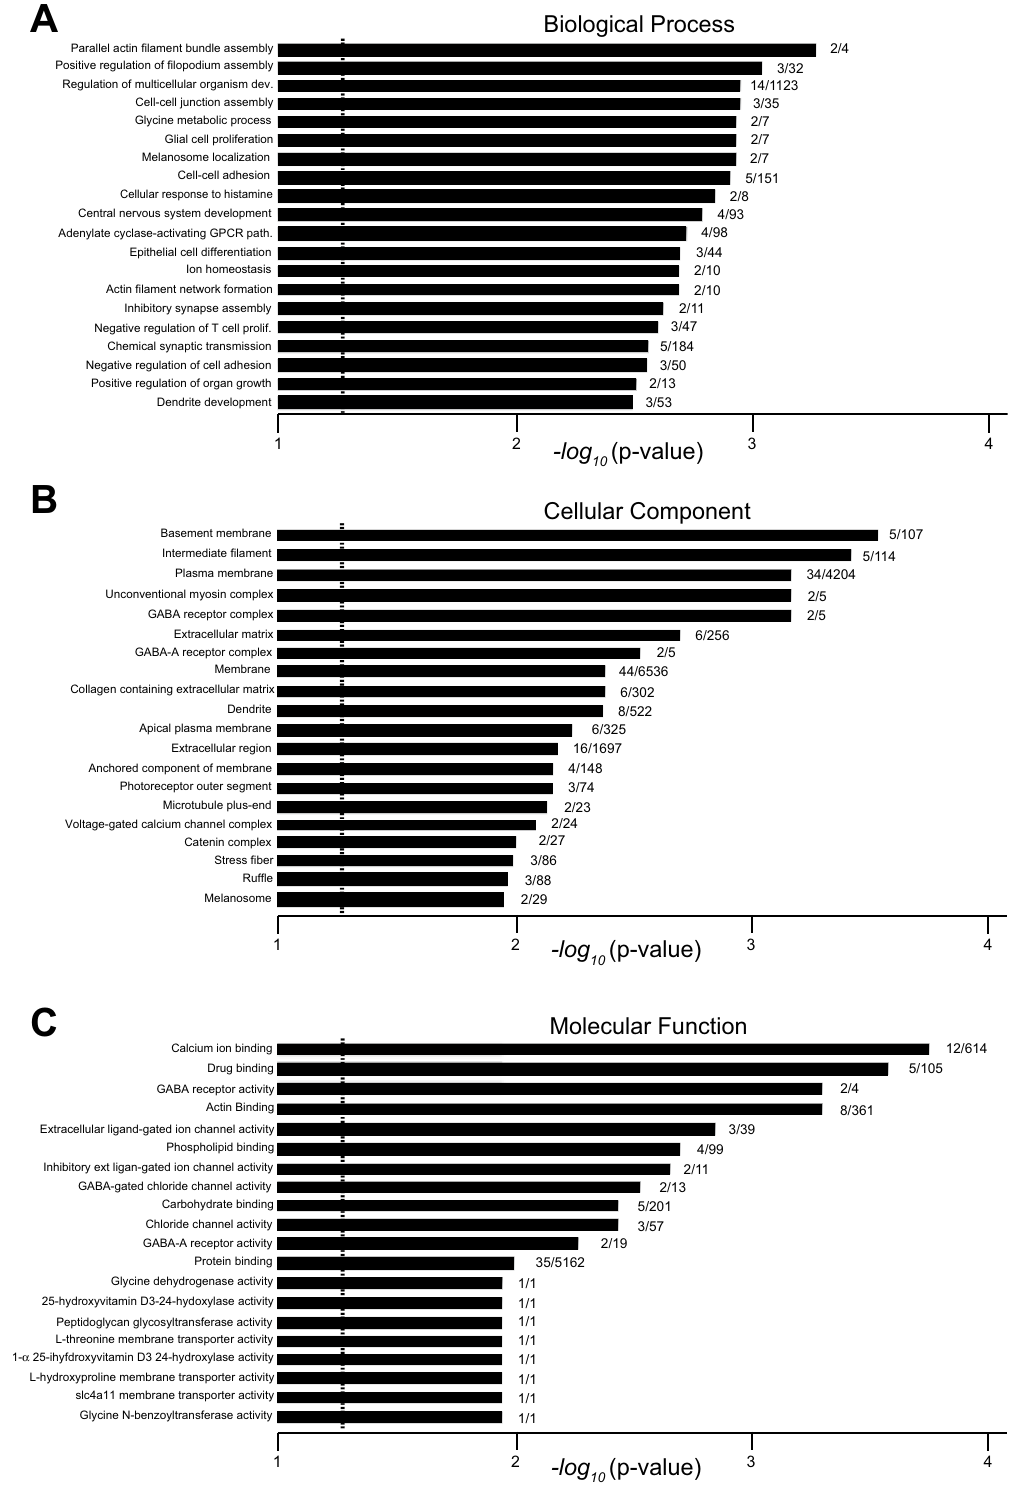
Figure 2 . Gene ontology (GO) analysis of genes differentially expressed in slc4a11 −/− mouse cornea. The X-axis represents the rank of GO terms based on statistical significance of the alterations of gene expression for genes in a GO category. Numbers beside bars are number of altered genes identified in the pathway/ number of genes in that GO pathway total. Top 20 affected GO category are indicated for: ( A ) biological process, ( B ) cellular component, and ( C ) molecular